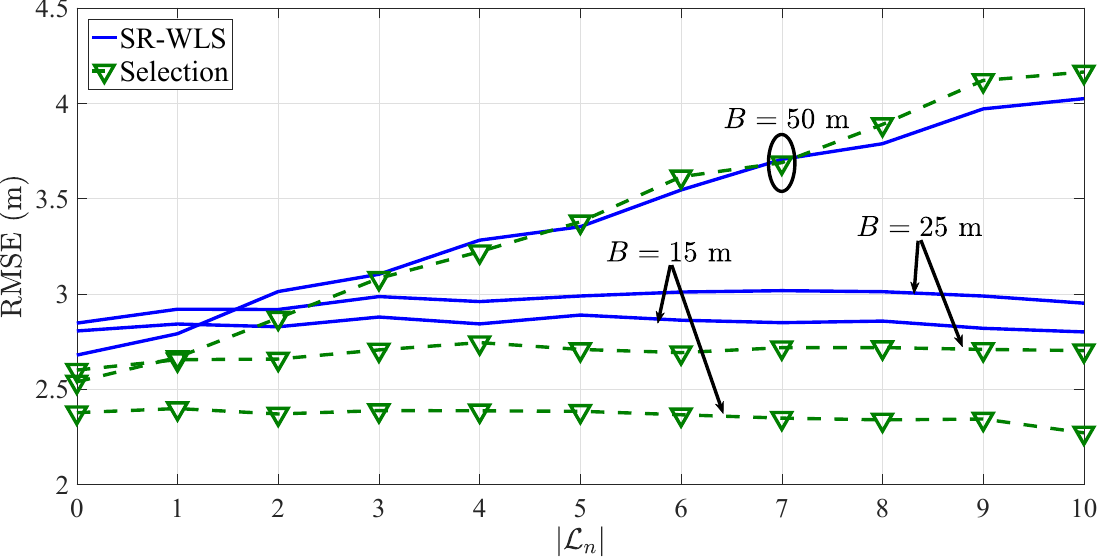
Figure 8. RMSE versus |L n | comparison in the first considered scenario, when N = 10, γ i ∼ U [ 2.7,3.3 ] , σ i = 6 (dB, m), and bias max = 6 (dB,